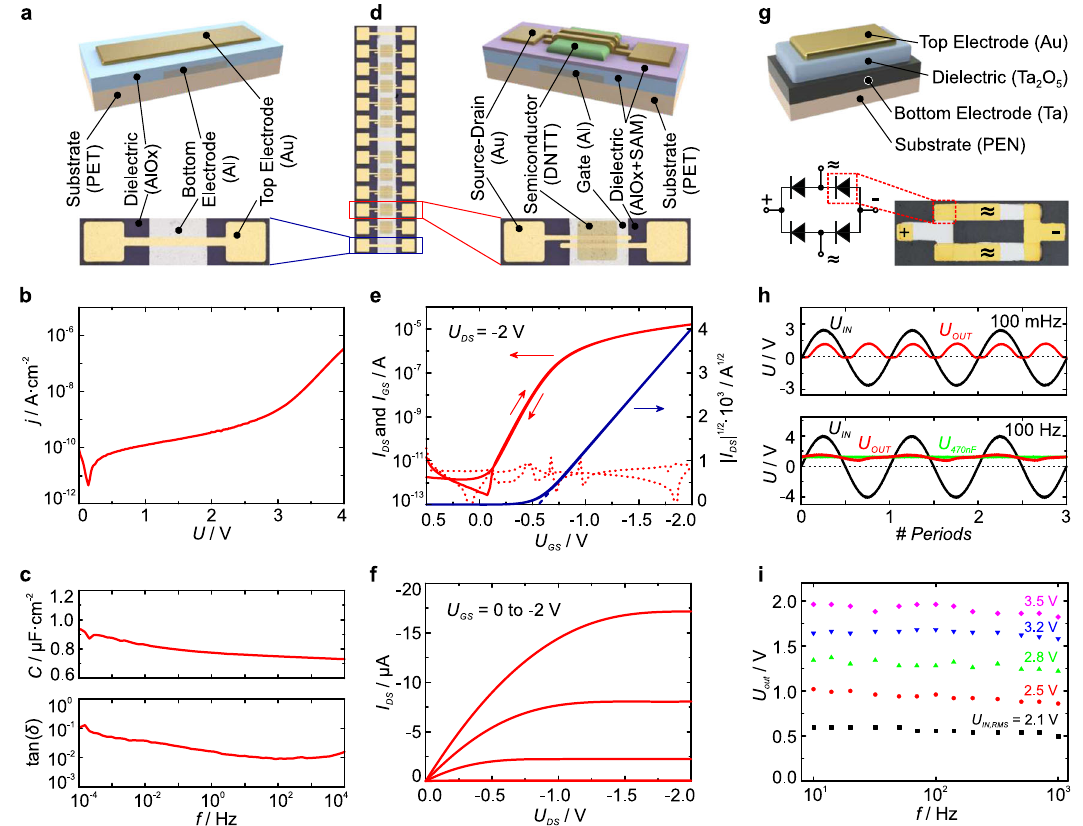
Fig. 2 Thin- fi lm capacitors, organic transistors, and diodes with printed oxide dielectrics and semiconductors. a Schematic and optical microscope image of capacitors fabricated by utilization of the anodic printing head. Gold contact pads are 500 µm × 500 µm. b Low-leakage current per area is achieved for capacitors with a dielectric thickness of 11 nm even at high electric fi elds of 360 MVm − 1 . c High capacitance per area of 740 nFcm − 2 and low dielectric loss for aluminum oxide capacitors. The dielectric constant of the written aluminum oxide is ε r = 9.2. d Schematic and optical microscope image of organic transistors with gate electrodes and dielectric layers structured by direct writing. e Transfer characteristic of a p-type low-voltage organic transistor on 1.4 µm PET foils. We reach on – off ratios of 1 × 10 7 (red solid trace), threshold voltages of − 0.72 V and mobilities of 2.3 cm 2 V − 1 s − 1 (extracted from the saturation regime, blue solid trace). The leakage currents remain below 10 pA (red dotted line). f Output characteristics of the same transistor. g Schematic of a tantalum oxide diode with circuit diagram and photograph of a full bridge recti fi er. Gold contact pads are 500 µm × 500 µm. h Output transients (red solid traces) of the recti fi ers measured at 100 mHz and 100 Hz are compared with the sinusoidal input signal (black solid traces). The AC ripple voltage is very small for input frequencies of 100 Hz (see also Fig. S6) owing to parasitic parallel capacitances of the diodes and is fully suppressed when using a 470 µF external smoothing capacitor (solid green transient). i Smoothed output signal as measured at various root-mean-square input voltages and frequencies from 10 Hz to 1